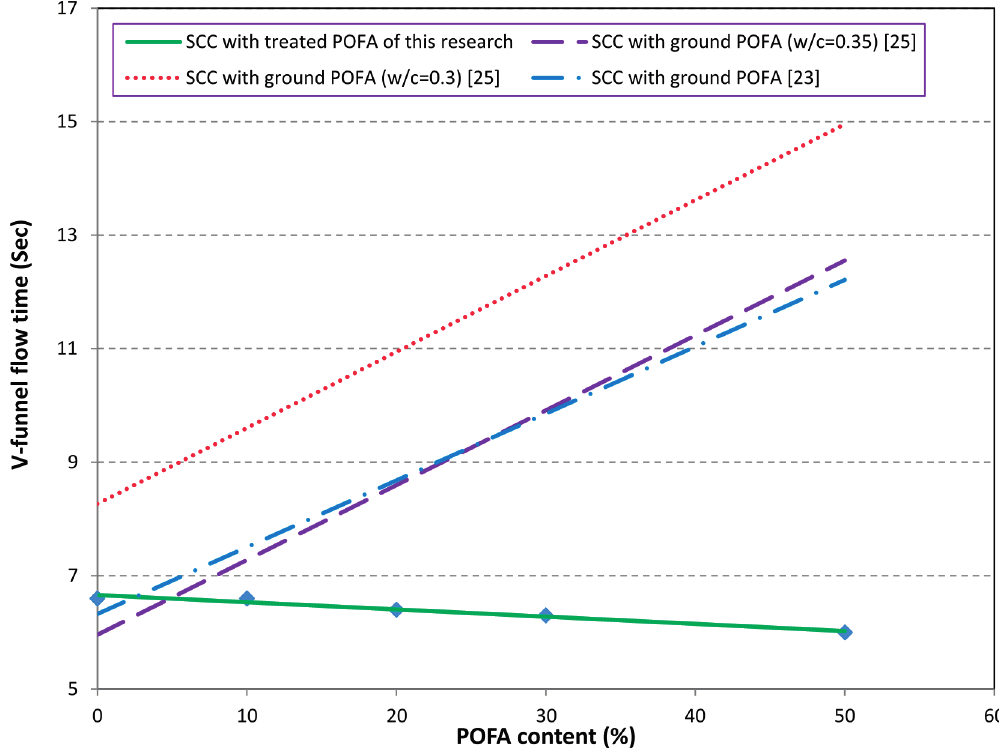
Figure 6. V-funnel for SCC with ground POFA and treated